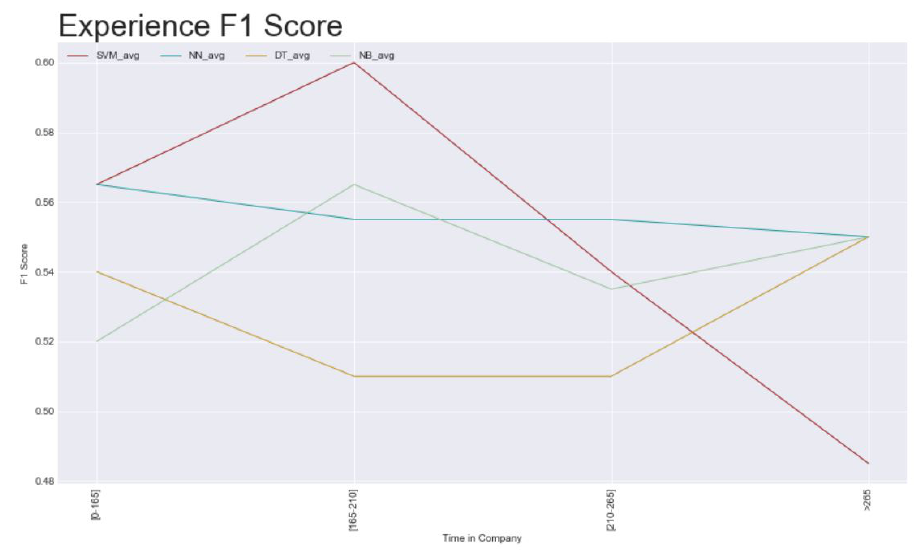
Figure 5. Variation of the F1 Score along the different tables related to variable time_in_company modelled and tested.